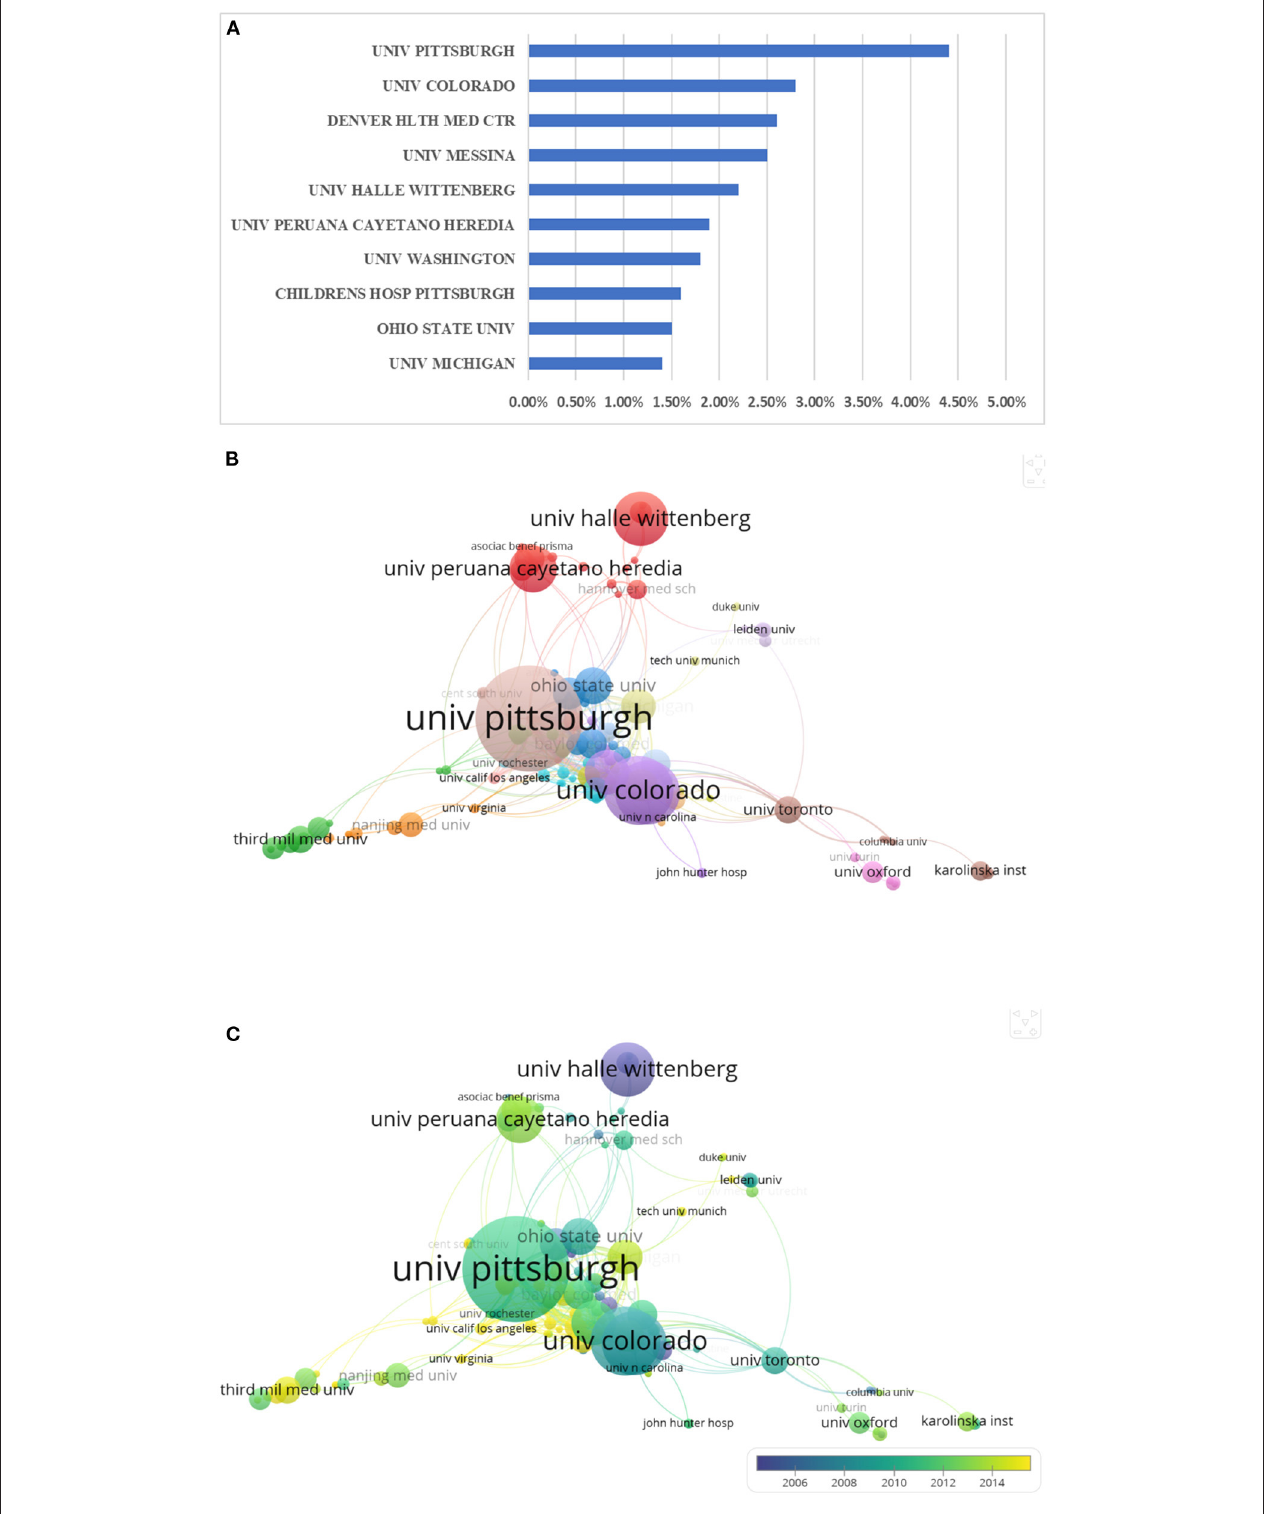
FIGURE 6 | The contributions of different institutions focusing on MODS. (A) Distribution of top 10 institutions focusing on MODS; (B) The cooperation of institutions in MODS, the circle with a large size represented the institution that published more articles; (C) Distribution of institutions was presented according to the appearance for the average